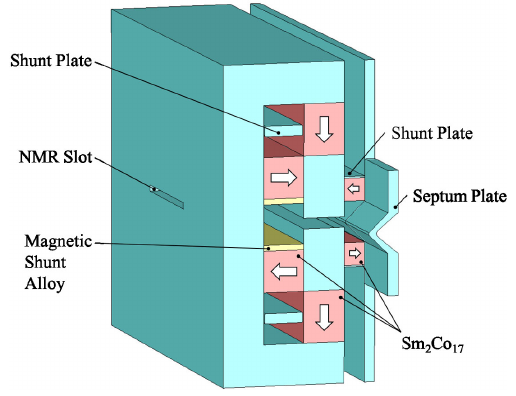
FIG. 3. Layout of magnetic circuit components.